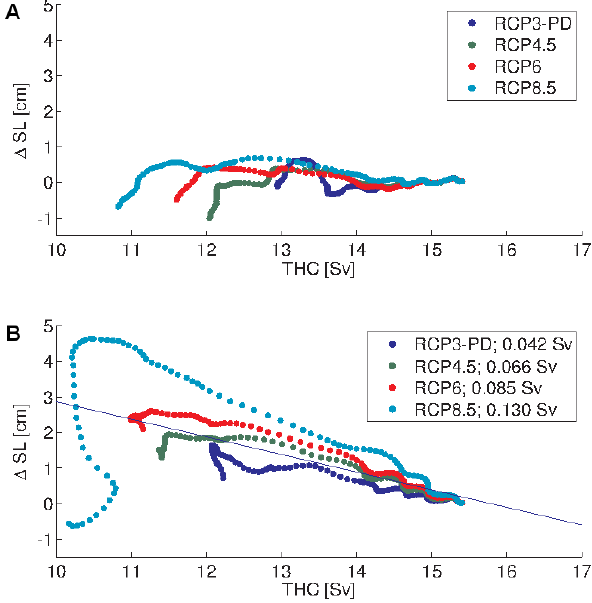
Fig. 10. 1 SL NC for 100yr relative to 2005 for the following forc- Fig. 10. ∆SL NC for 100yr relative to 2005 for the following forcings: (A) 4 RCP-scenarios, (B) RCP-scenarios ings: (A) 4 RCP-scenarios, (B) RCP-scenarios plus freshwater forc- plus freshwater forcing (slope of linear fit: (cid:0) 0.50cmSv (cid:0) 1 ). ing (slope of linear fit: − 0.50cmSv − 1